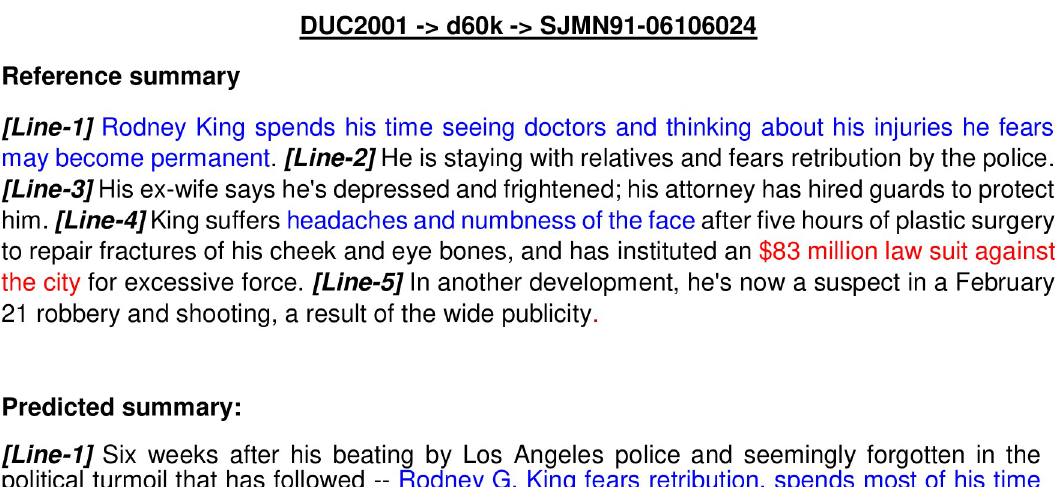
Fig 6. An example of reference summary and predicted summary for document SJMN 91—06106024 of topic d 60 k under DUC2001